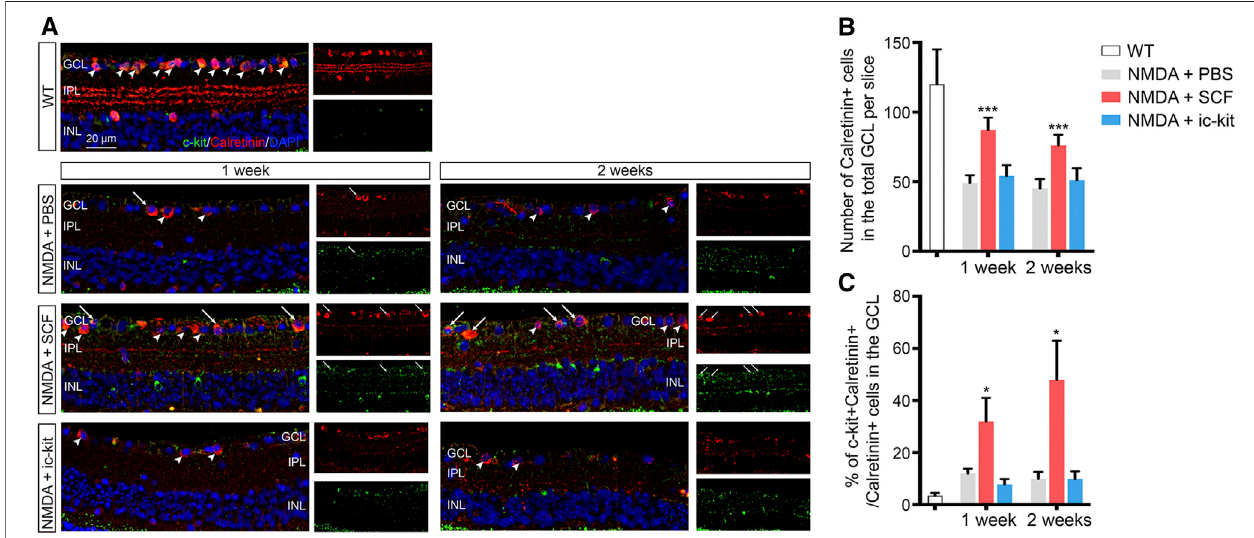
FIGURE5| SCFTreatmentCompensated forthe LossofRGCs in NMDA-treatedMice. (A) Immuno fl uorescence detection ofCalretinin + RGCs (red) inthe GCLof indicated mice. Scale bars represented 20 μ m. (B) Statistical analysis of the number of Calretinin + RGCs in indicated groups. (C) Statistical analysis of the ratio of c-kit + cellsinCalretinin + RGCsinindicatedgroups.Datawereshownasmean±SD( n ≥ 5foreachtimepoint).* p < 0.05,** p < 0.01,*** p < 0.001,comparedwithNMDA+PBS controls.